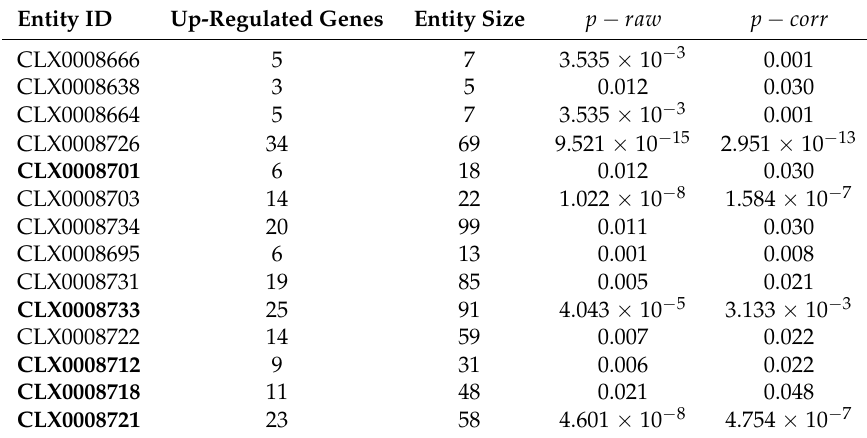
Table 2. Entities enriched for genes up-regulated at 14–16 h during appressorium maturation. Entities highlighted in bold are enriched for appressorium genes at both 4–8 h and 14–16 h